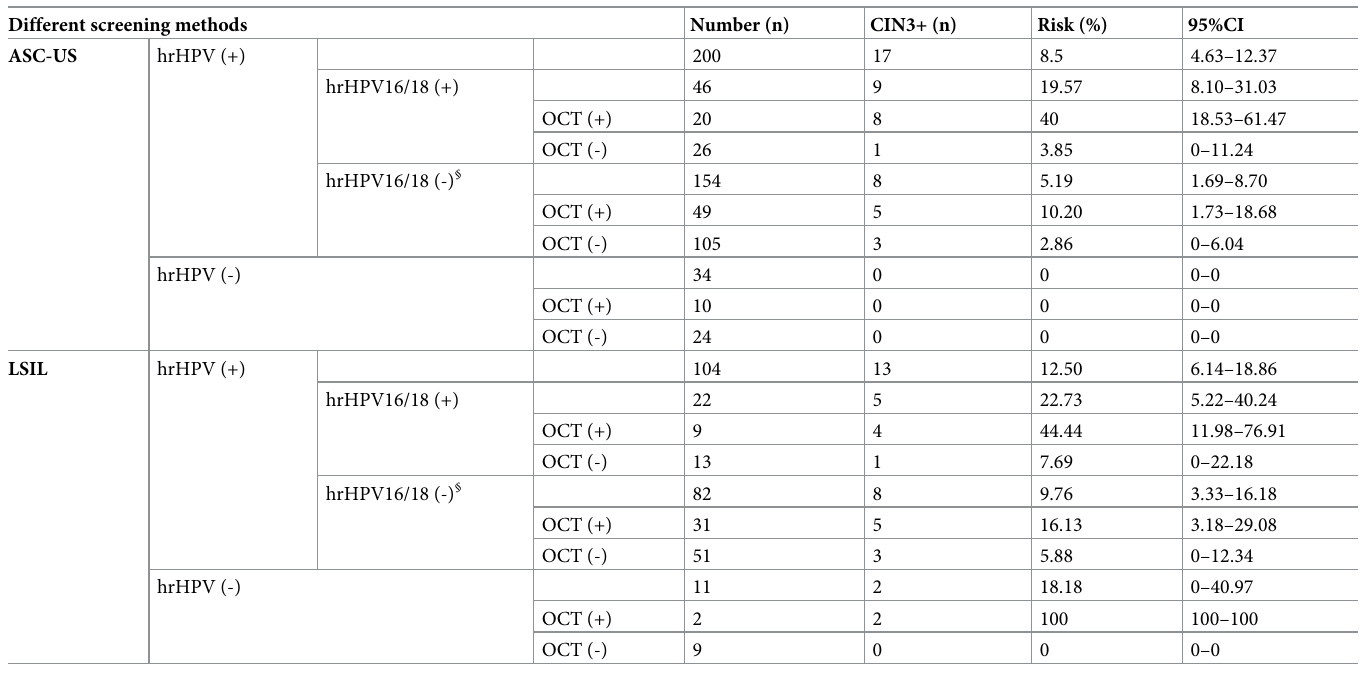
Table 6. The immediate risk of CIN3+ of different screening methods. Different screening